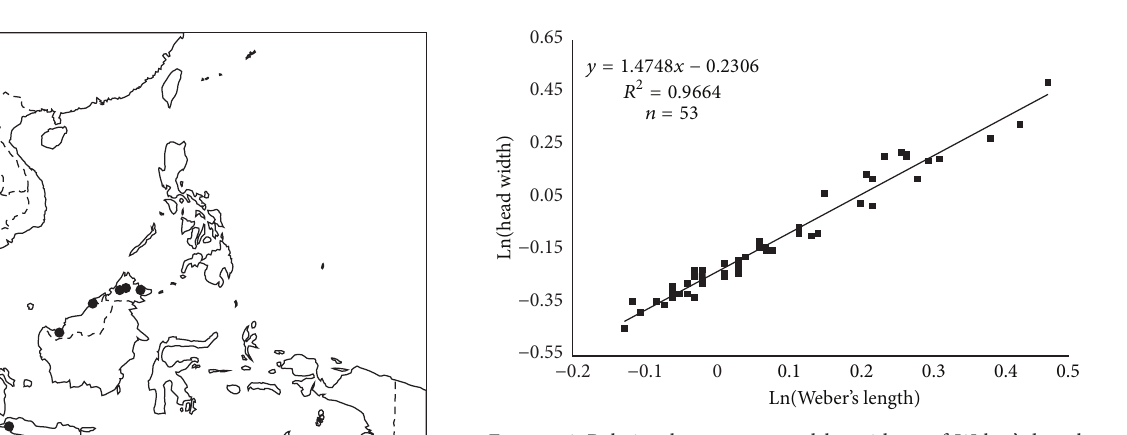
Figure 6: Relation between natural logarithms of Weber’s length (WL) and head width (HW) in workers ( 𝑛 = 53 ) of C . coriaria Mayr, 1872.